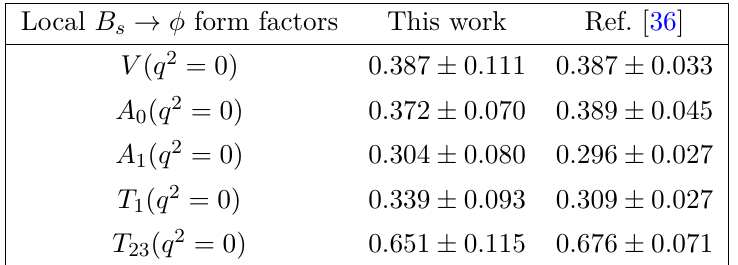
Table 6 . Comparison between the local form factors results of ref. [36] and our results at q 2 = 0